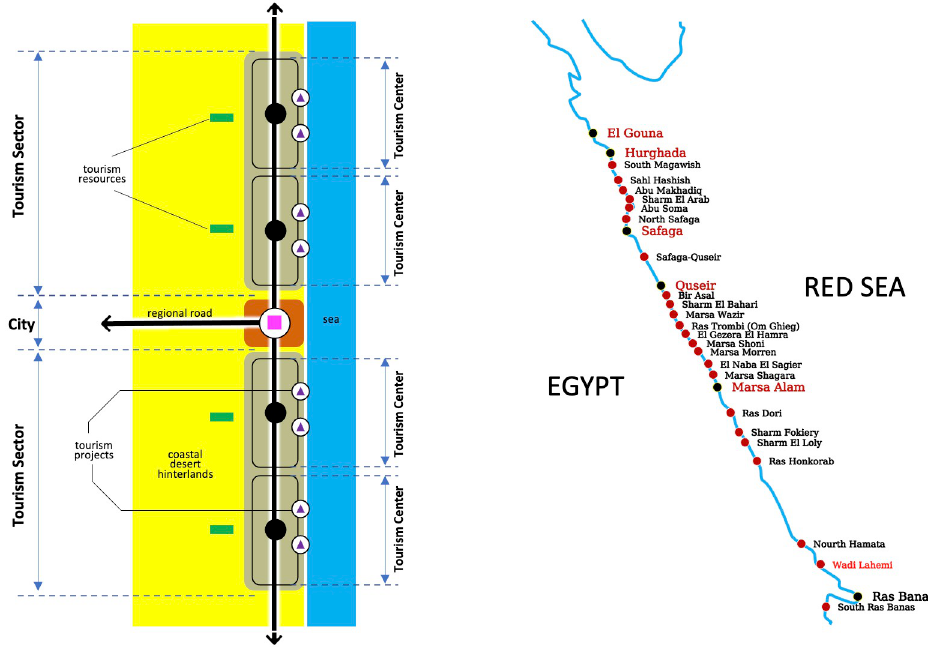
Fig 2. Tourism centres establish idea. Source: Researcher based on